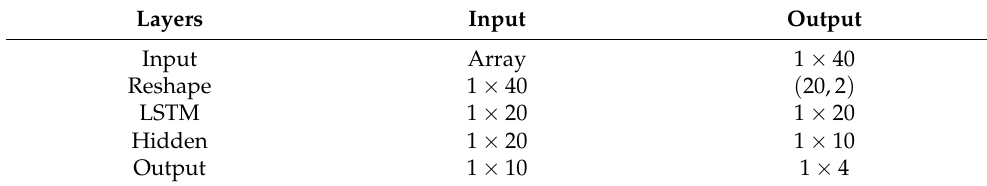
Table 3. Architecture of LSTM network.